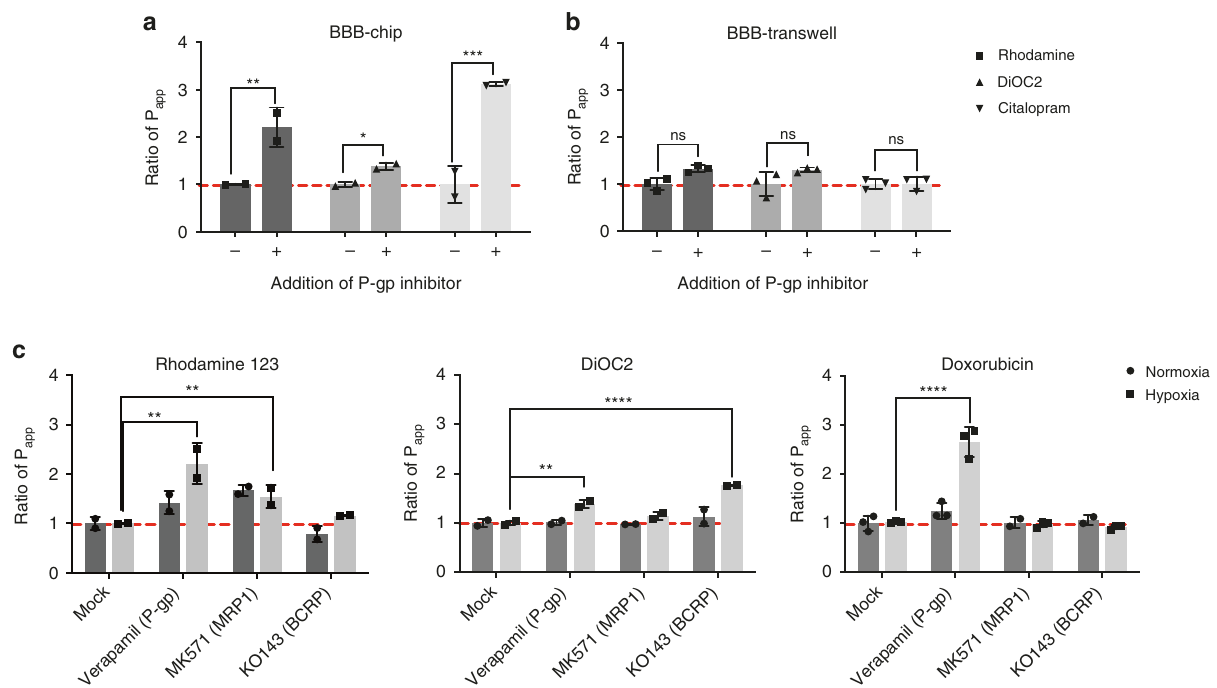
Fig. 3 Metabolic barrier function of the human BBB Chip. P-gp activities measured in the BBB Chip ( a ) versus BBB Transwells ( b ) that were pretreated with verapamil to inhibit the P-gp activity in the presence or absence of the P-gp substrates, rhodamine 123, DiOC2, or citalopram. c BBB ef fl ux pump substrate selectivity and functionality measured in the BBB Chips using rhodamine 123 as a substrate of P-gp and MRP1 (left); DiOC2 as a substrate of P-gp and BCRP (middle); and doxorubicin interacting with P-gp (right) with or without addition of ef fl ux transporter inhibitors (verapamil for P-gp, MK 571 for MRPs, and Ko143 for BCRP). Ratio of P app indicates fold changes in the apparent permeability ( P app ) of molecules resulting from chemical modulation of speci fi c ef fl ux pump activity. Data are presented as means ± SE, N = 2 for the chip experiments for rhodamine 123, DiOC2, and citalopram, as well as N = 3 for the BBB Transwell experiments and BBB chip experiments for Doxorubicin. The statistical analysis is two-way ANOVA with Tukey ’ s multiple comparisons